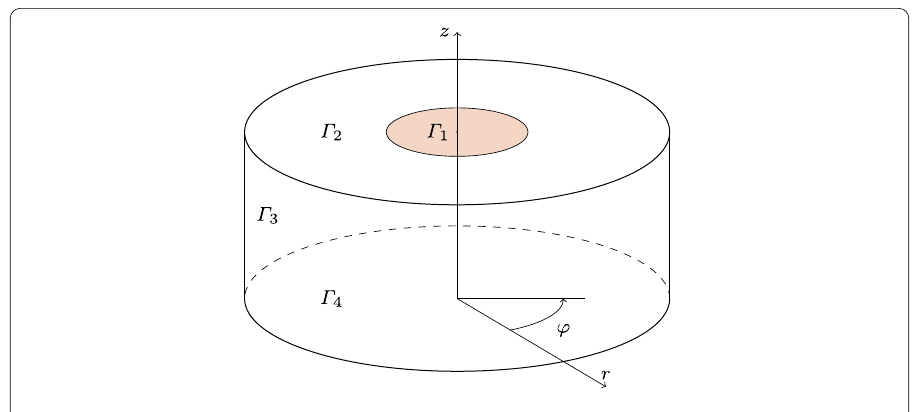
Figure 1 Cylinder (cid:2) and its